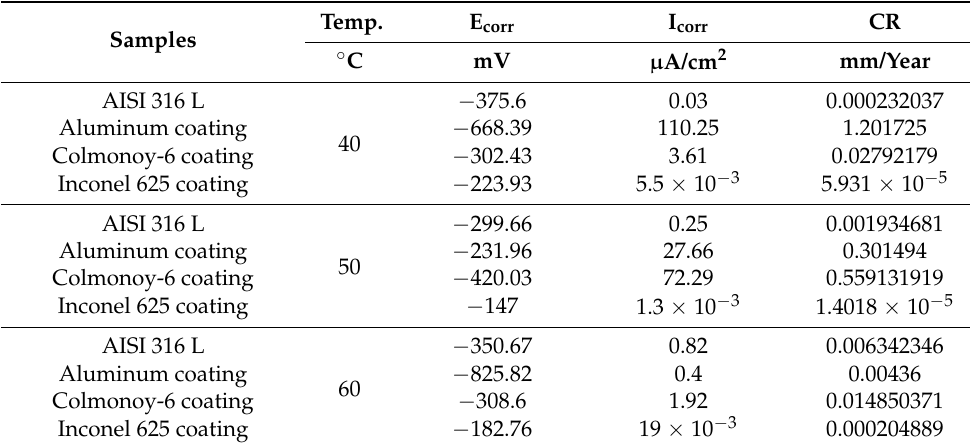
Figure 5. Polarization curves for the substrate and coatings at ( a ) 40 °C, ( b ) 50 °C, and ( c ) 60 °C. Table 3. Summary of results of electrochemical tests.